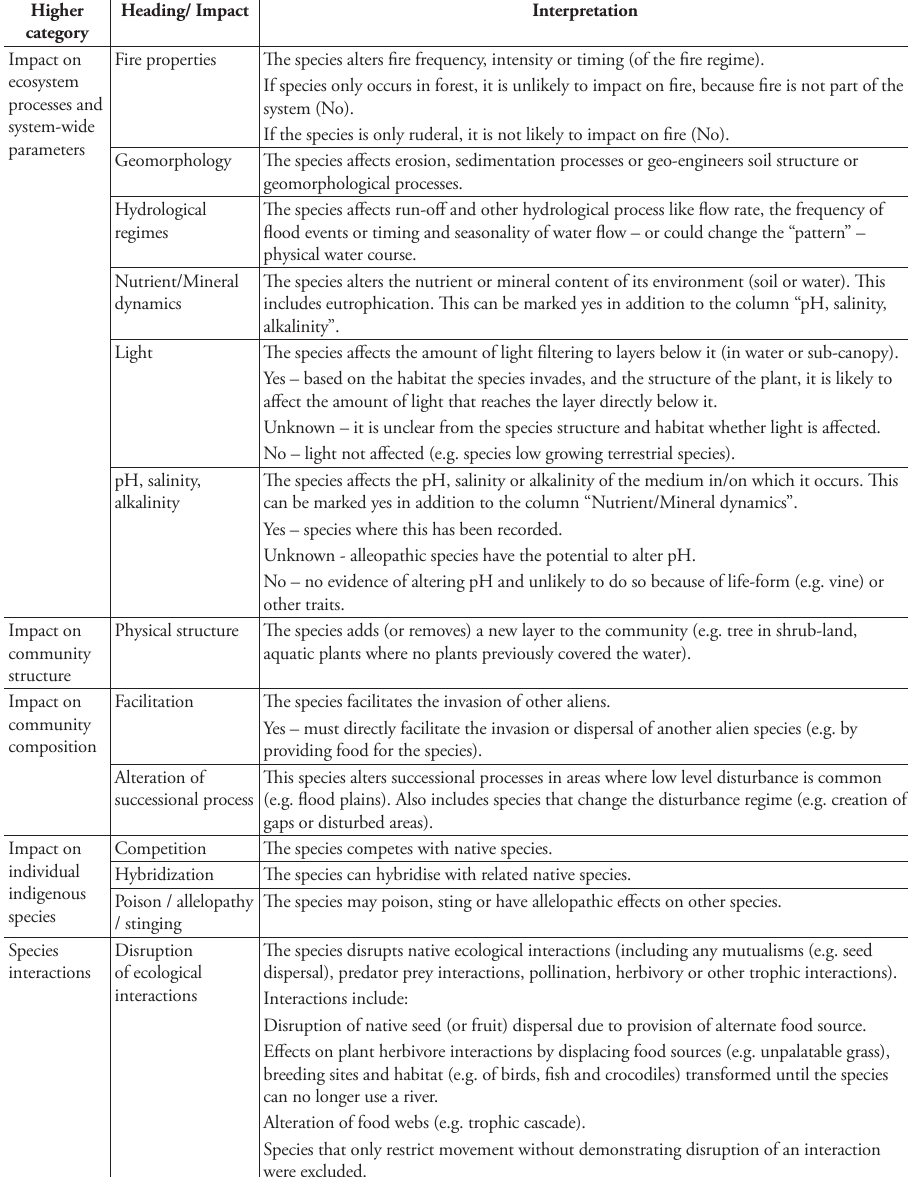
Table 2. Definition and interpretation of impact